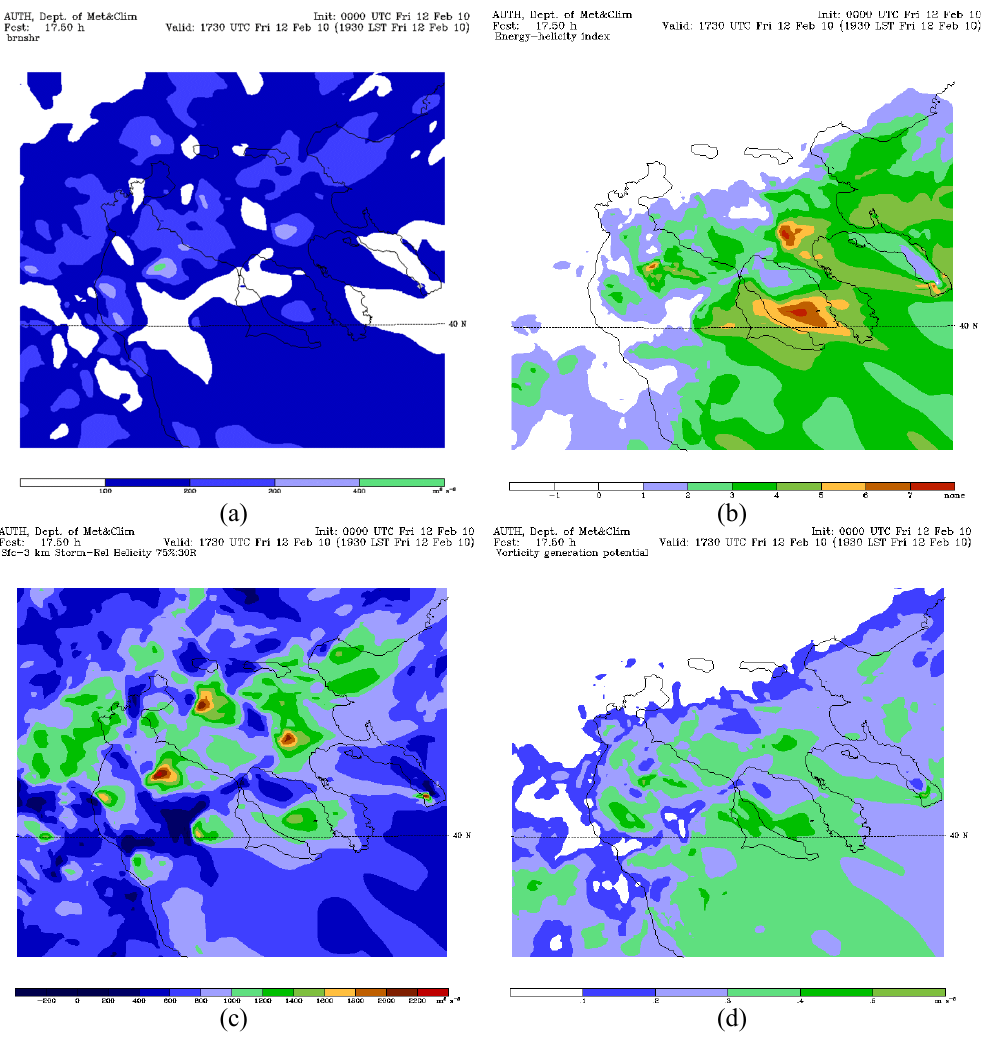
Figure 7. WRF-ARW outputs based on Ferrier microphysics scheme at 17:30 UTC on 12 February 2010. Bulk Richardson Number Shear (m 2 s -2 ) (a), Energy Helicity Index (b), Storm-Relative Environmental Helicity (m 2 s -2 ) (c) and Vorticity Generation Potential (m s -2 ) (d). Calculated using the RIP software.